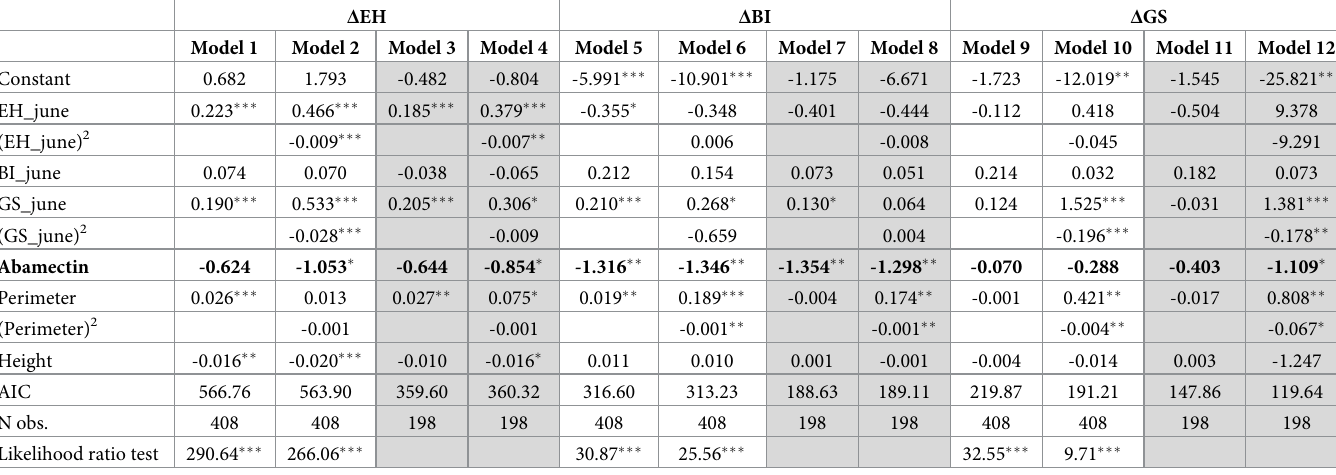
Table 4. Regression results with NBRM for EH, BI and GS considered separately.